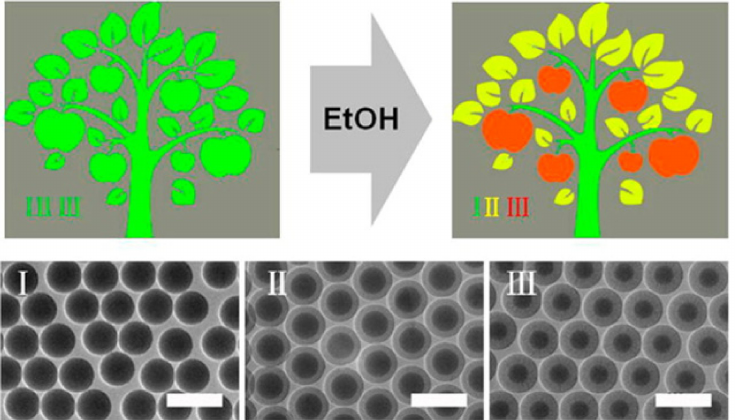
Figure 5. The structural color of the inkjet-printed tree pattern under N 2 and saturated EtOH atmospheres, where a pattern composed of tree trunks, tree leaves and fruit, respectively, is formed by self-assembly of solid silica particles, and mesoporous silica particles with di ff erent core and shell thicknesses. Reused with permission from Reference [39], Copyright 2014, American Chemical